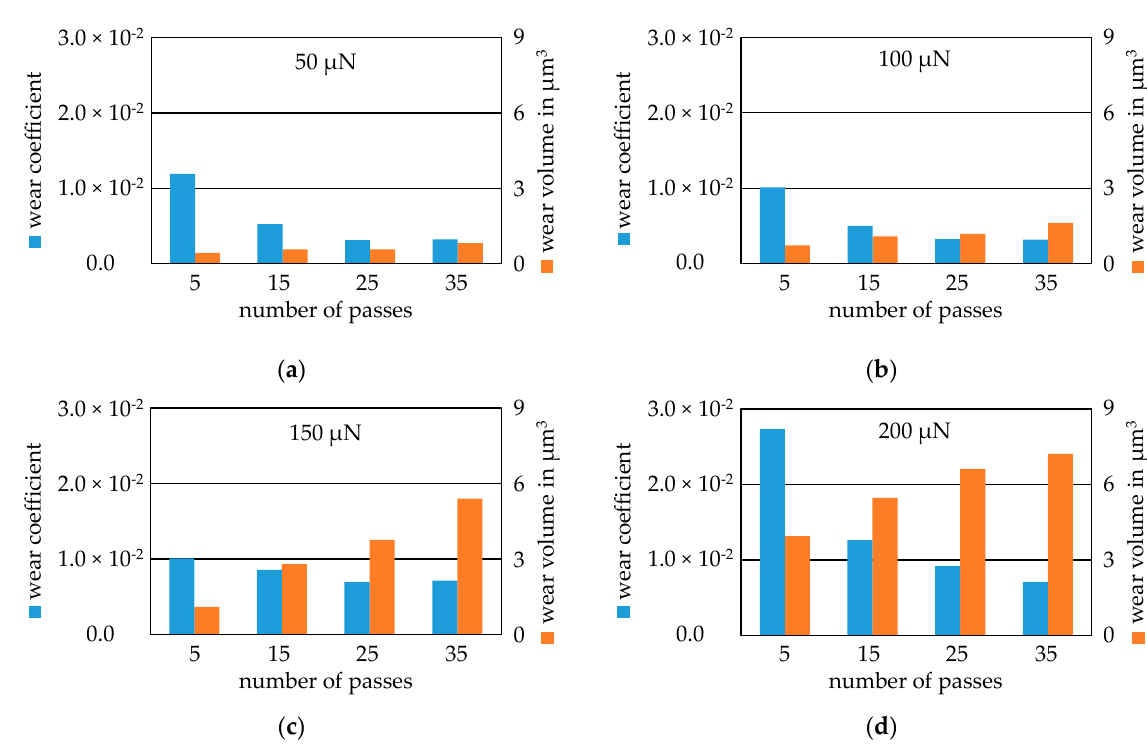
Figure A5. Development of the average wear volumes and average coefficients of wear over the normal forces of the MoO 3 ‐ coating: ( a ) 5 passes; ( b ) 15 passes; ( c ) 25 passes; ( d ) 35 passes.